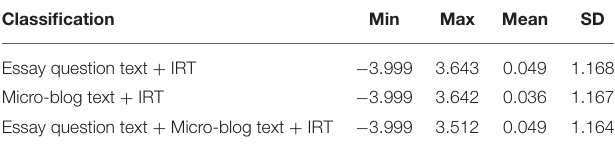
TABLE 6 | The summary of θ parameters in text–IRT